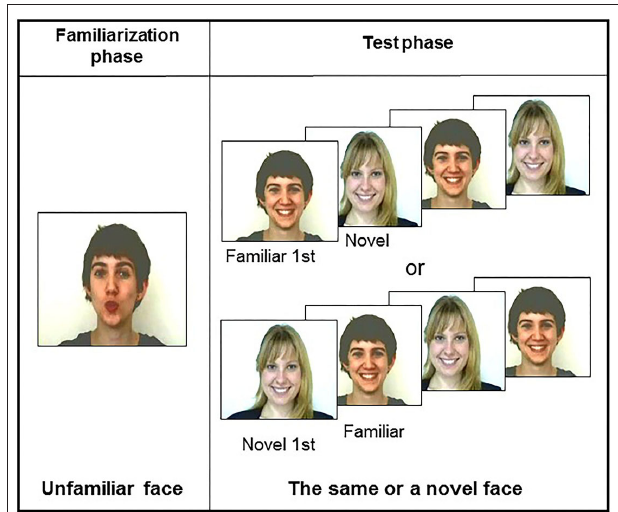
FIGURE 1 | Presentation of the procedure used for the three